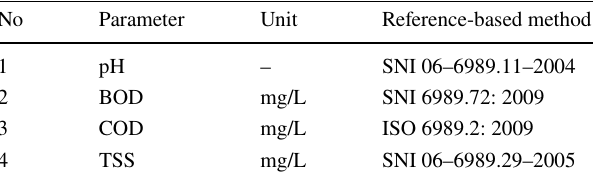
SNI , Indonesian National Standard, ISO , International Organization for Standardization (BSN 2017;